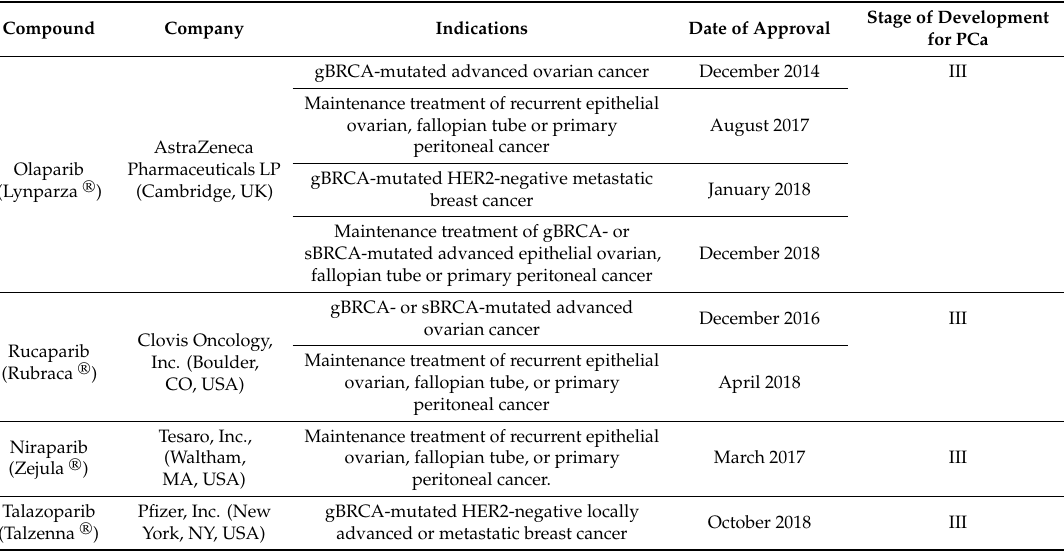
Table 1. PARP inhibitor drugs approved by the